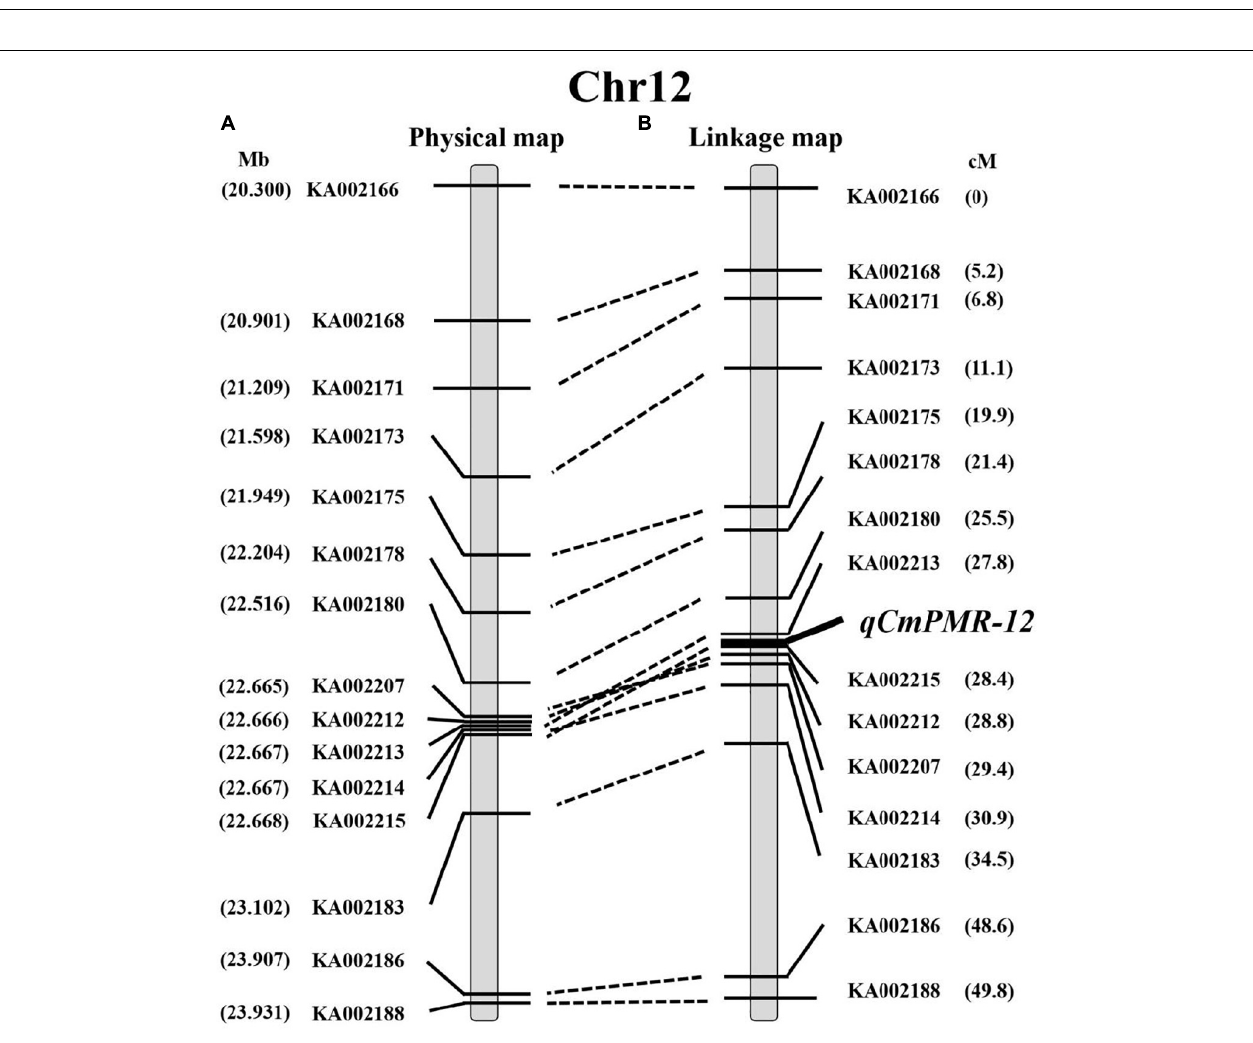
FIGURE 4 | Quantitative trait locus (QTL) analysis of resistance to powdery mildew and the distribution of KASP markers linked to the target region. The gray areas represent the QTL region. The positions of KASP markers are shown by vertical lines.